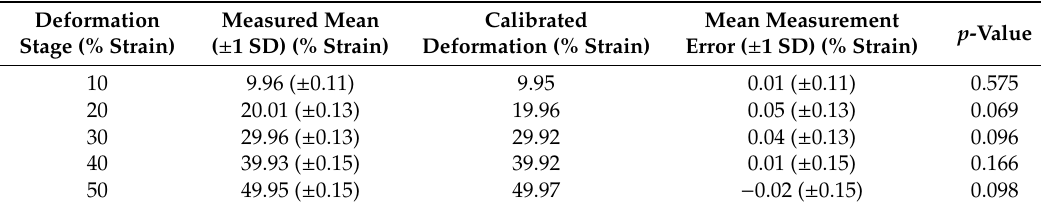
Table 5. Measurement accuracy results for each deformation stage at a 95% confidence level for measured deformations and incorporating edge detection error for calibrated